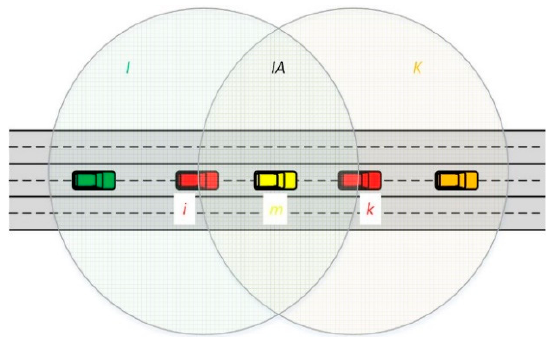
Figure 1. An illustration of a shared node between two vehicles. The vehicle in yellow is shared by both i and k vehicles.